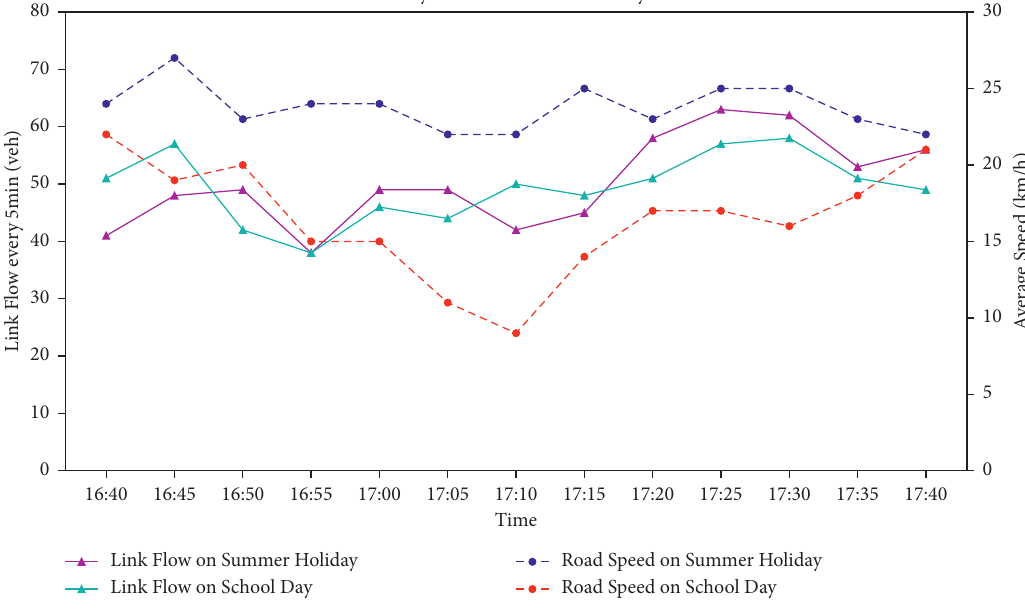
Figure 9: Traffic flow and average speed on weekdays.